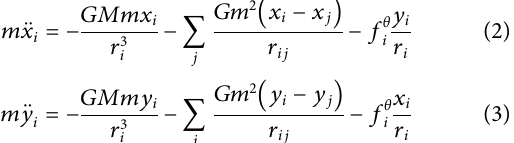
Solar System: Figure 1 . For example, for a perfect 2:1